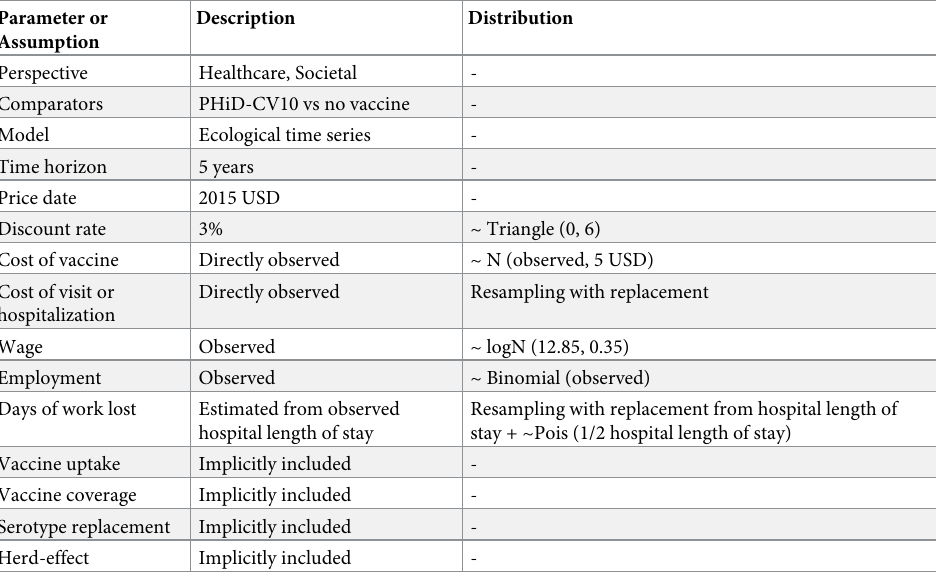
Table 2. A summary of the parameters and assumptions of the cost-effectiveness